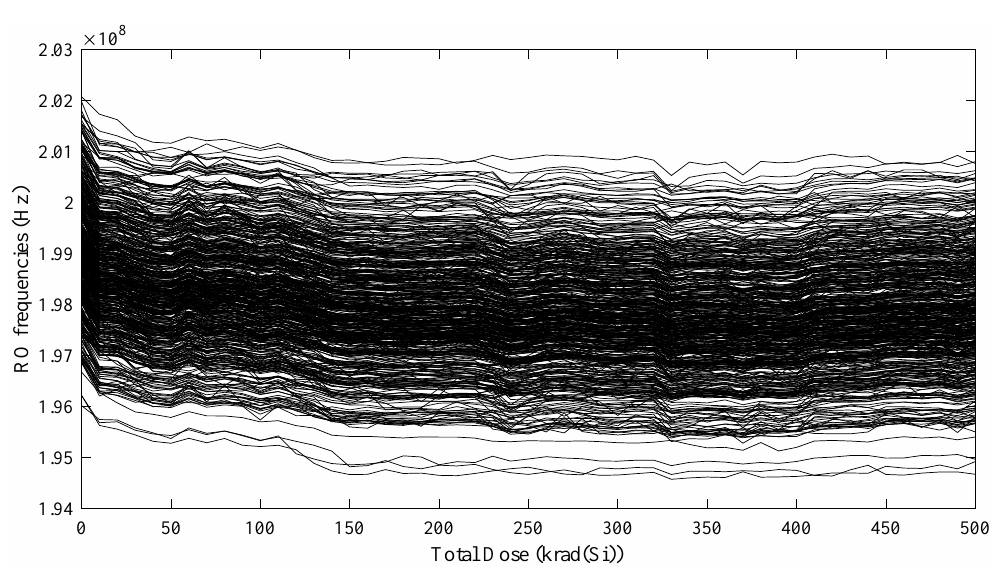
Figure 7. RO frequencies vs.